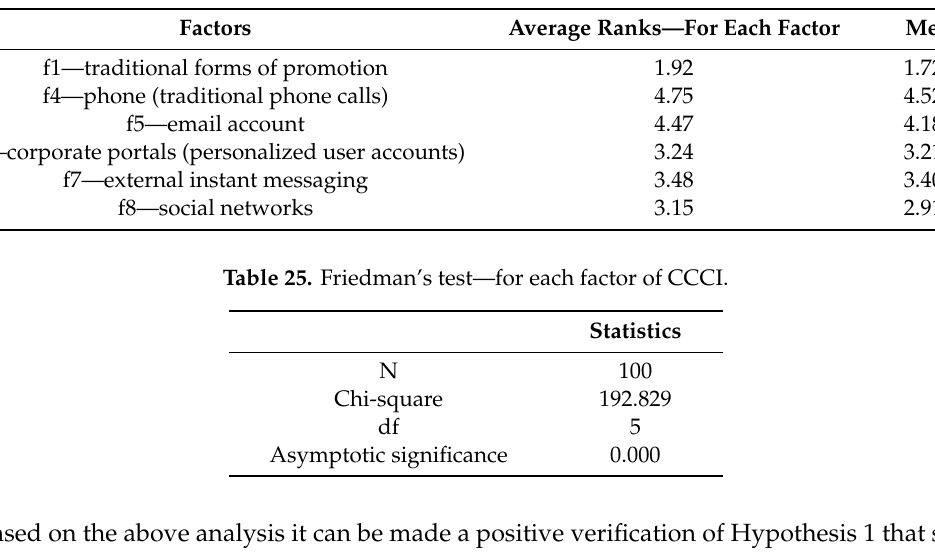
Table 29. Average ranks—for each factor of CRII. Factors